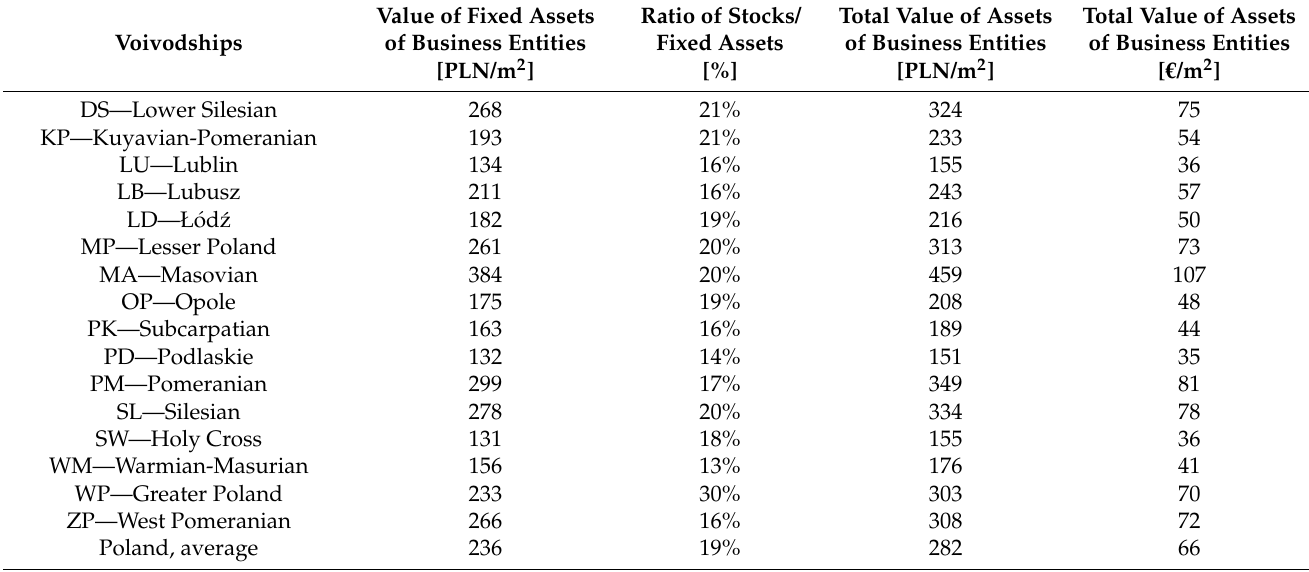
Table 5. Value of assets of business entities in residential areas in 16 voivodships (in 2019 prices).